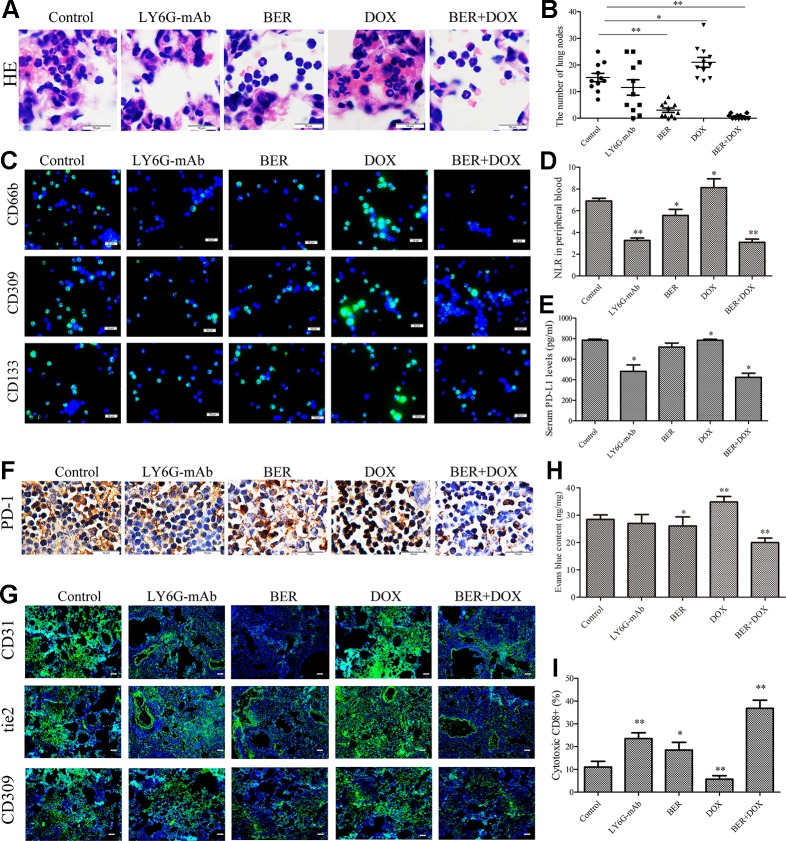
Neutrophils affect urethane-induced lung carcinogenesis. (A) Alveolar neutrophils indicated by hemotoxylin and eosin (H&E) staining of lung tissue (n = 5, 100×). (B) The number of lung nodes (n = 10). (C) Alveolar neutrophil protein expression of CD66b, CD309, and CD133 indicated by immunofluorescence (n = 5, 40×). (D) NLR in peripheral blood (n = 5). (E) Serum PD-L1 levels (n = 5). (F) Spleen tissue PD-1 expression examined by immunohistochemical analysis (n = 5, 100×). (G) Lung tissue protein expression of CD31, tie-2, and CD309 indicated by immunofluorescence (n = 5, 40×). (H) Lung tissue permeability to Evans blue (n = 5). (I) Spleen cytotoxic CD8+ cell rate (n = 5). The data present mean ± SD, the experiments were repeated three times, and statistical significance was determined by a t-test. *P < 0.05, **P < 0.01 vs. control. DOX, doxorubicin; BER, berberine.